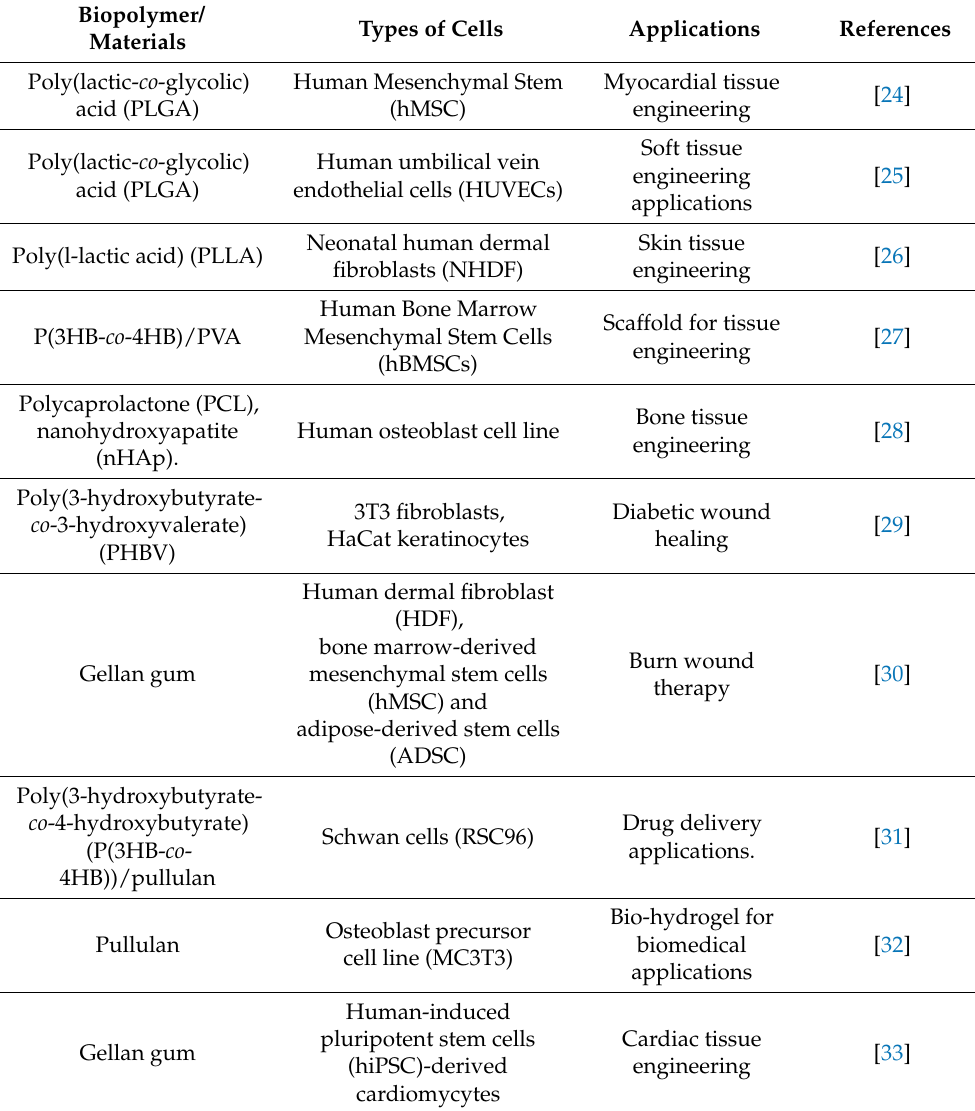
Table 1. List of common examples materials incorporated with gelatine to improve surface function-